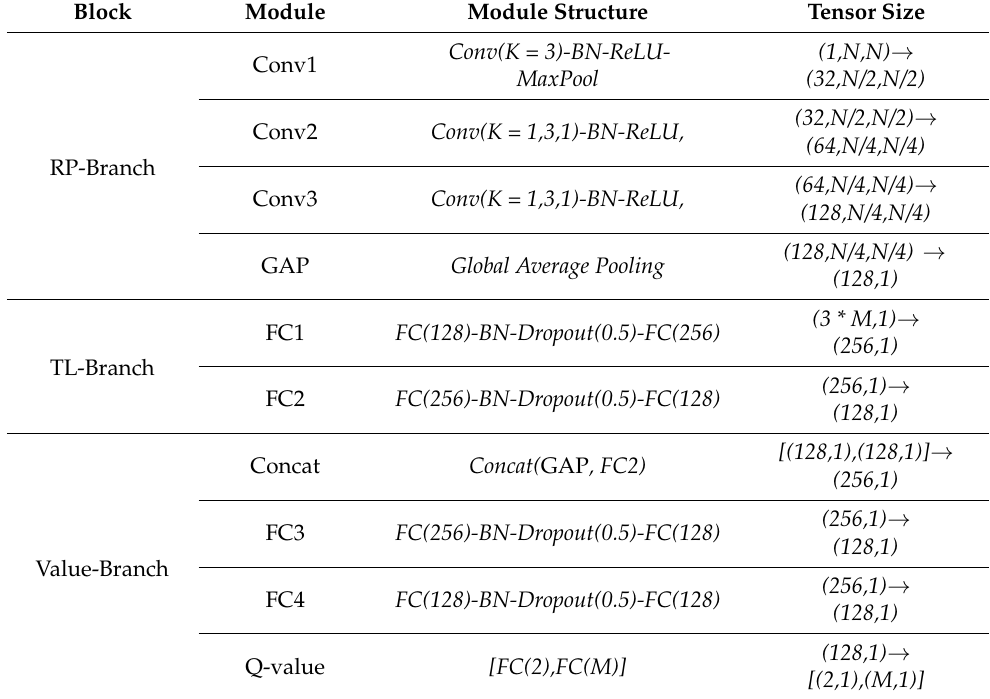
Table 3. Detailed network of Multi-Branch